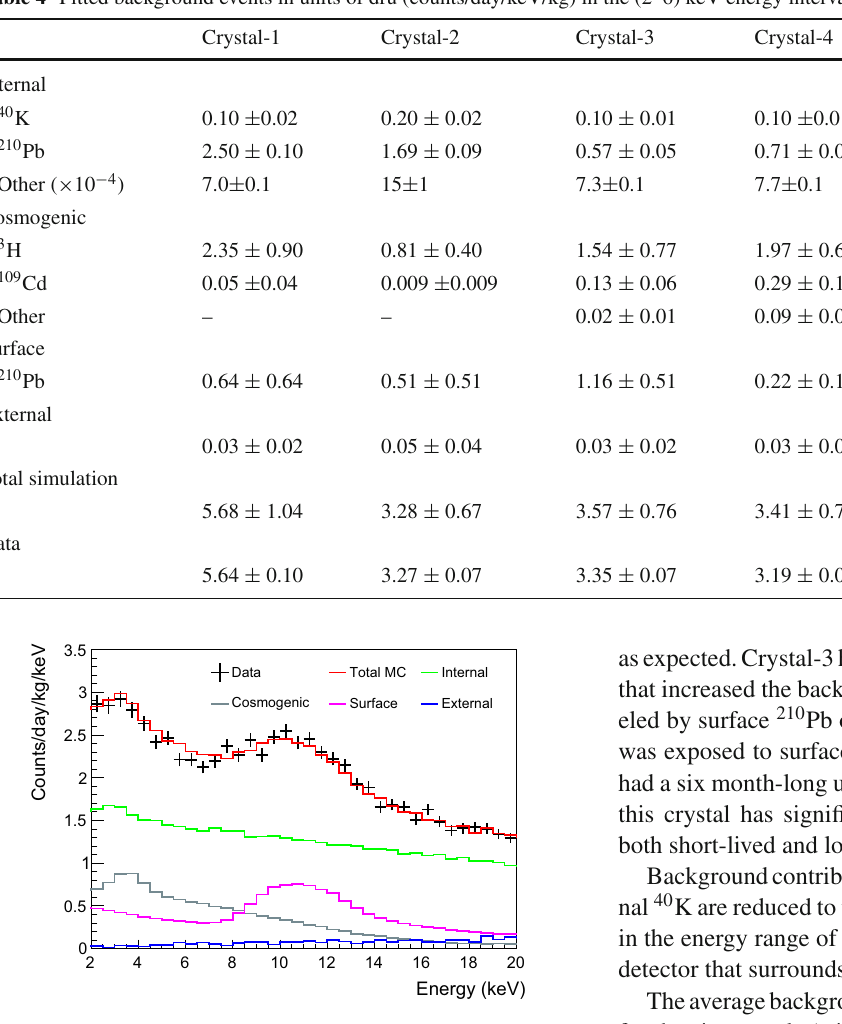
Fig. 9 Comparison of data and Monte Carlo simulation of the low- energy background spectra of